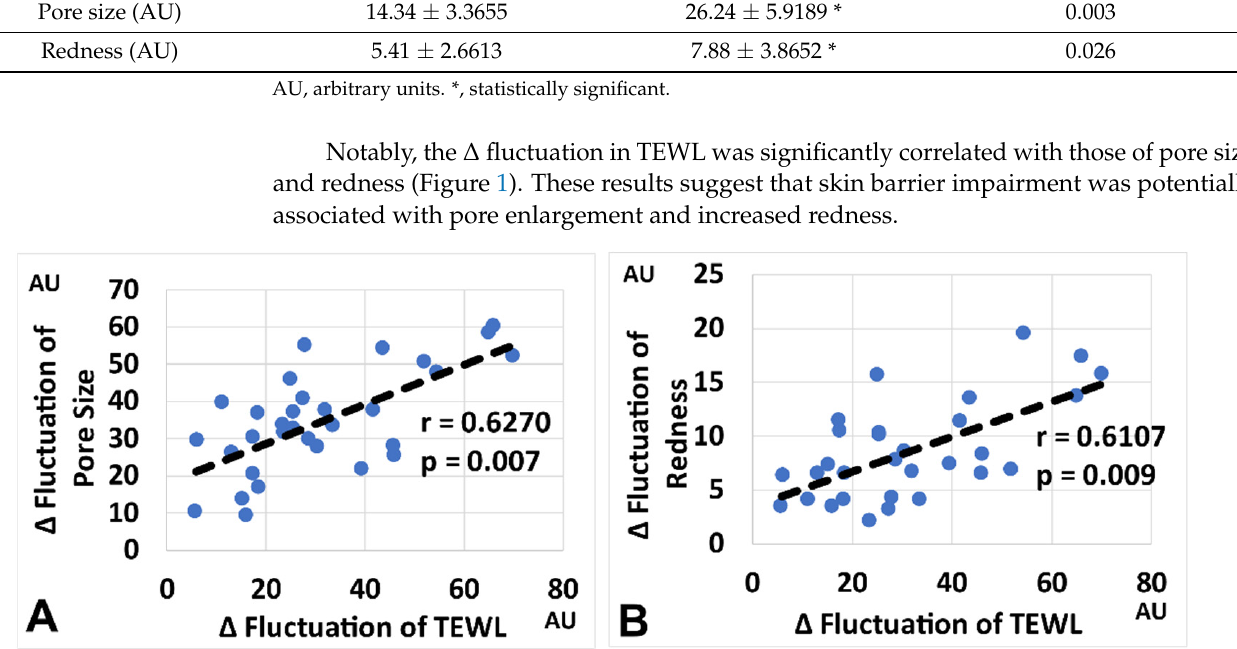
Table 1. Intra-day averages of facial skin variables.